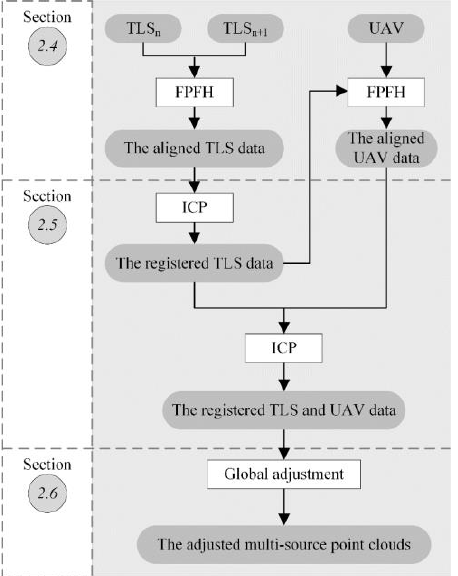
Figure 2. Workflow of this paper. ‘Section 2.4’ describes the process of coarse alignment, ‘Section 2.5’ describes the process of fine registration, and ‘Section 2.6’ describes the process of global adjustment. ‘TLS n ’ and ‘TLS n+1 ’ describe the point clouds of terrestrial laser scanning (TLS) in different scan locations, ‘UAV’ describes the point cloud data obtained by unmanned aerial vehicle (UAV). ICP is the acronym of the iterative closest point algorithm and FPFH is the acronym of the fast point feature histogram algorithm.